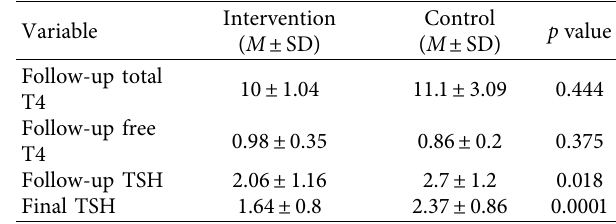
Table 3: Comparison of the follow-up hormones related to thyroid function between the intervention and control groups (mean ±